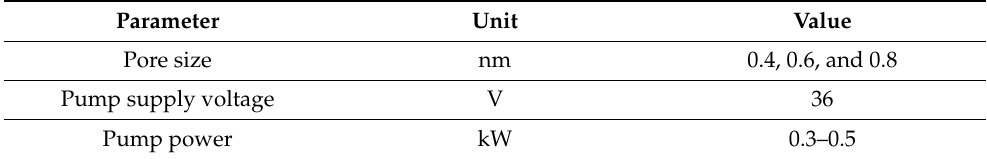
Table 2. Nanofiltration general technical